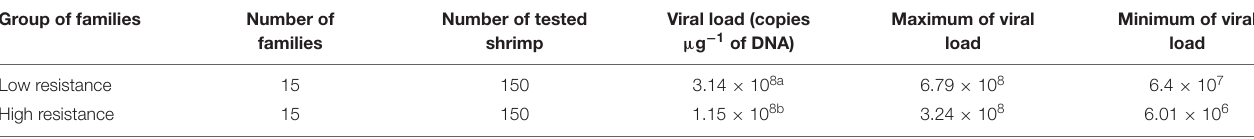
TABLE 1 | WSSV viral load (in log10 scale) in low resistant and high resistant families. Group of families